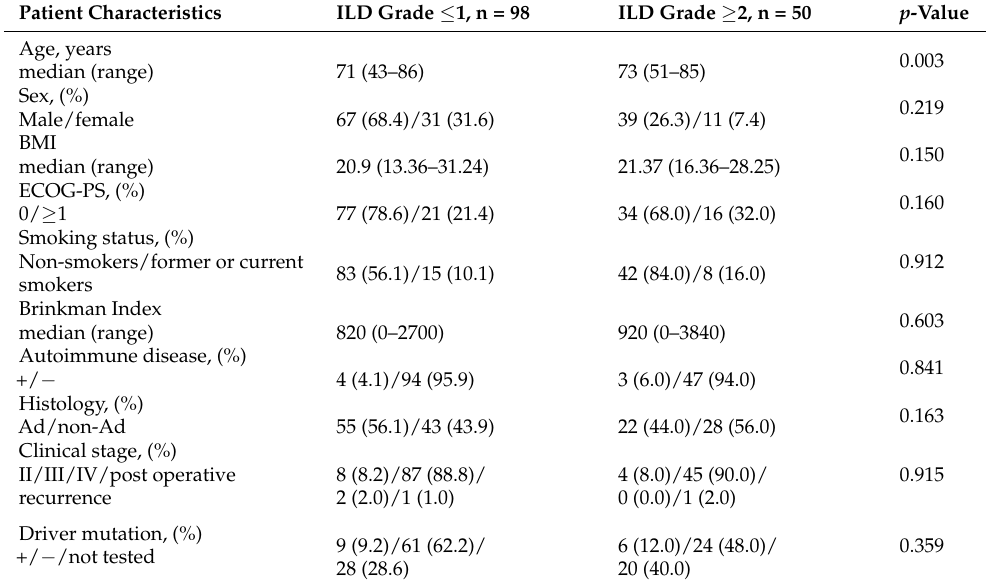
Table 3. Comparison of characteristics between patients with and without grade ≥ 2